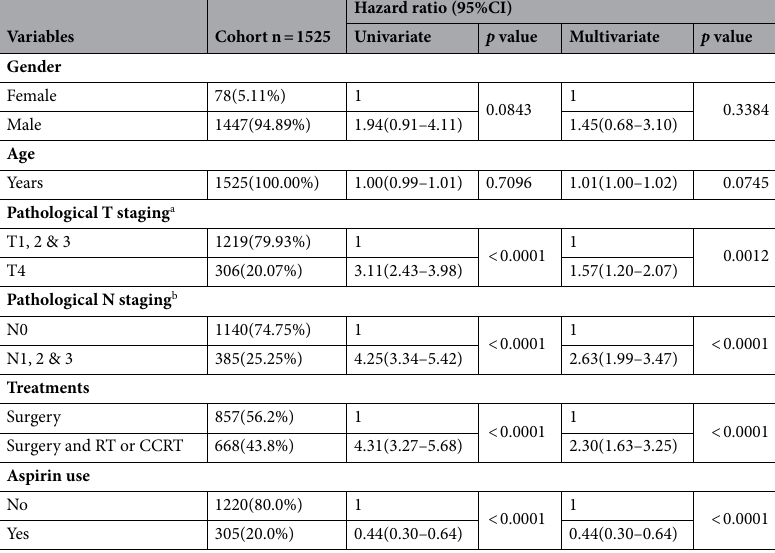
Table 3. Univariate and multivariate Cox proportional hazards of prognostic factors for OSCC survival, Model B: adjusted for pathological TN staging system and other covariates as shown in the table. 95% CI 95% Confidence interval, RT Radiotherapy, CCRT Concurrent chemoradiotherapy. a Pathological T Staging 7th Edition. b Pathological N Staging 7th